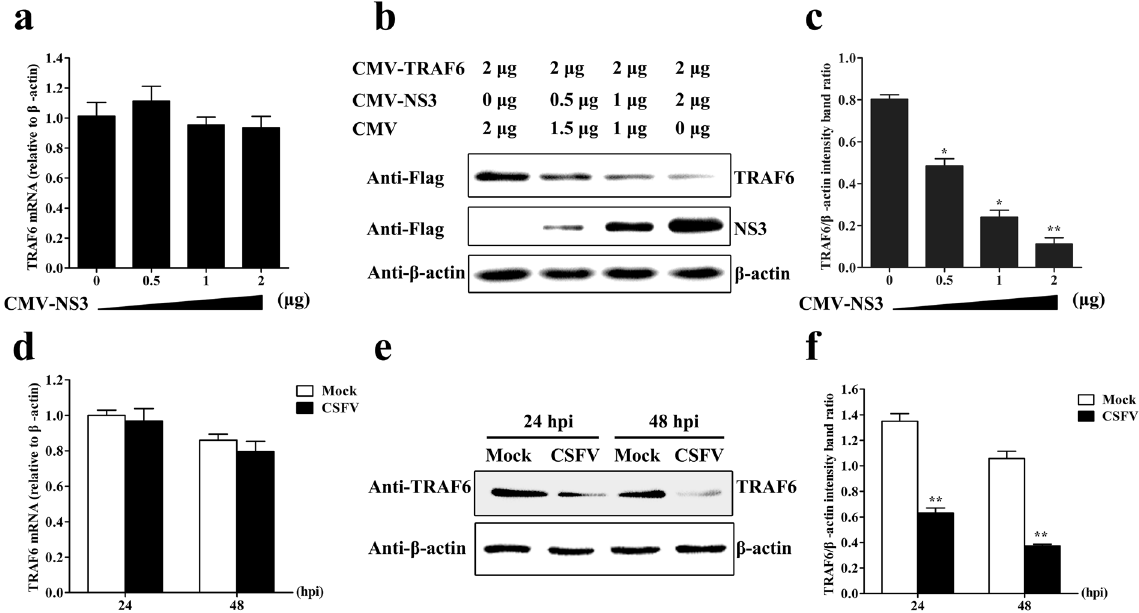
Figure 3. CSFV or NS3 degrades TRAF6. ( a , b ) TRAF6 mRNA and protein expression in NS3-expressing PAMs. PAMs were co-transfected with CMV-TRAF6 and a different amount of CMV-NS3. RT-PCR and Western blot analysed TRAF6 mRNA and protein expression at 24 hpt. β -actin served as an internal control. ( c ) The relative levels of TRAF6 protein were estimated by histograms representing density readings of the gel bands, and the ratios were calculated relative to β -actin control. ( d , e ) TRAF6 mRNA and protein expression in CSFV-infected PAMs. PAMs were mock-infected or CSFV-infected. RT-PCR and Western blot analysed TRAF6 mRNA and protein levels at 24 and 48 hpi. ( f ) The relative levels of TRAF6 protein were estimated by histograms representing density readings of the gel bands, and the ratios were calculated relative to β -actin control. The data represent the mean ± SD of three independent experiments. * P < 0.05 and ** P < 0.01 calculated using Student’s t-test